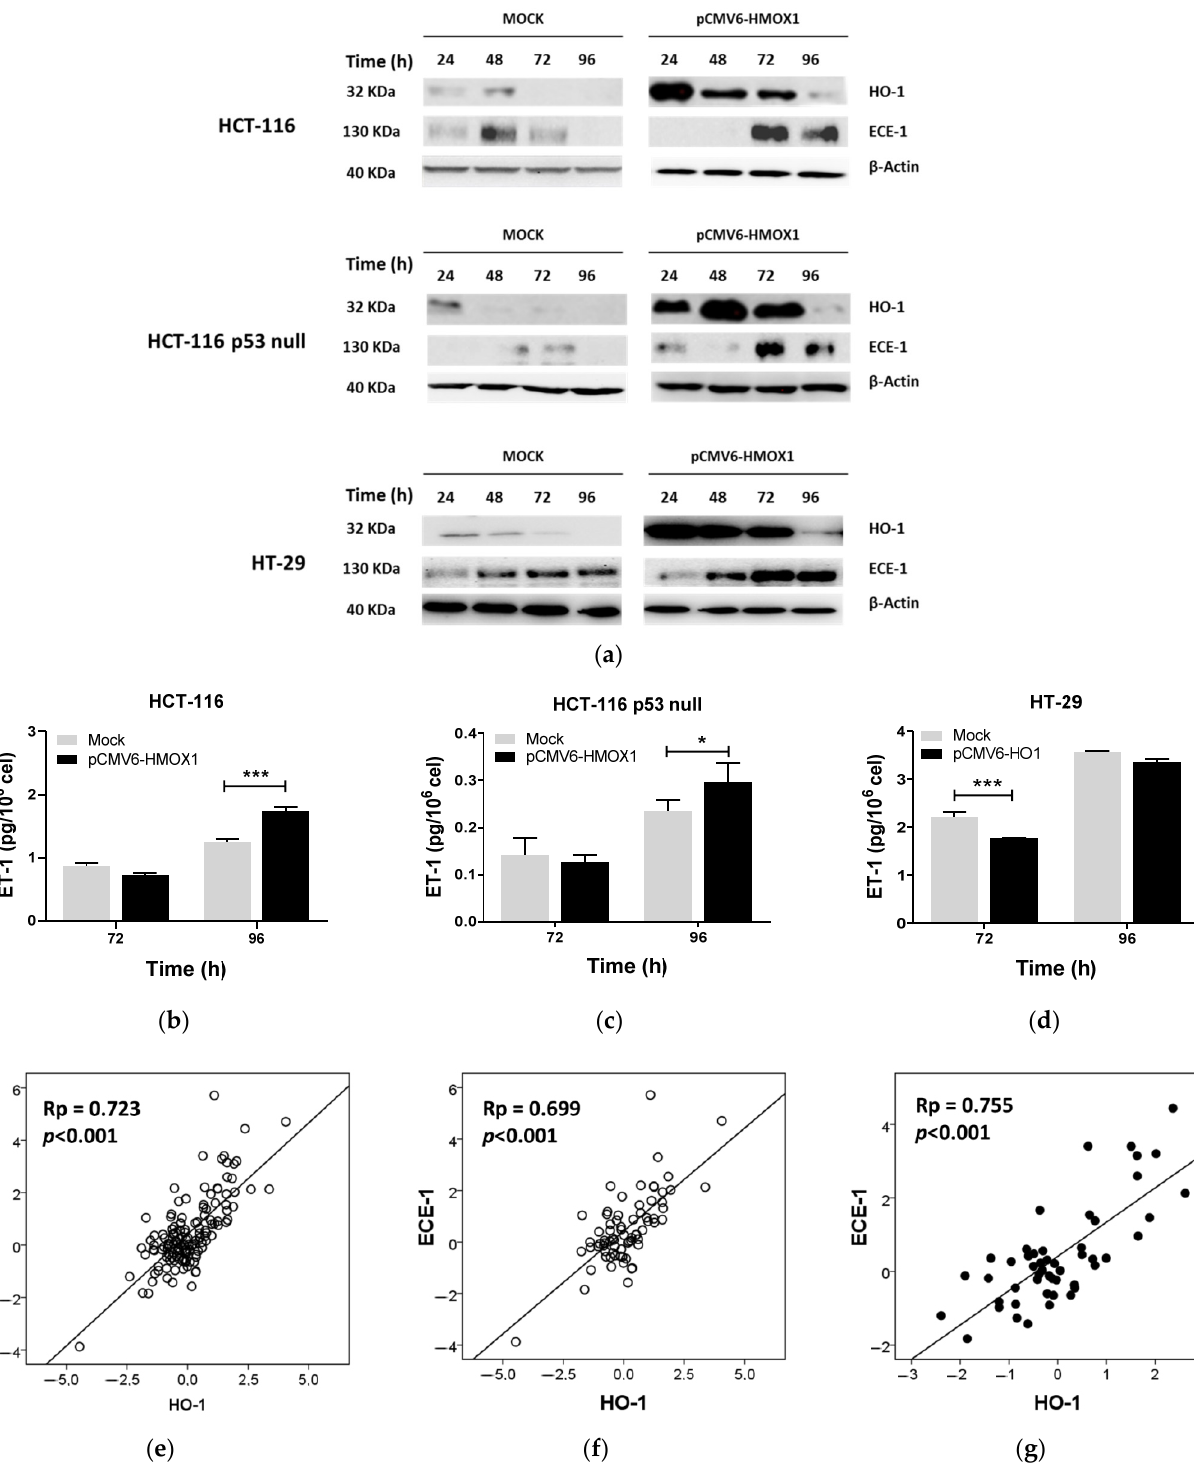
Figure 4. HO-1 overexpression induces ECE-1 expression and ET-1 production in CRC cells regardless of p53 status. Cells were transiently transfected with pCMV6- HMOX1 or an empty vector and collected 24–96 h later for ( a ) HO-1 and ECE-1 protein expression by western blotting or ET-1 measurements in the supernatants of ( b ) HCT-116, ( c ) HCT-116 p53 null, ( d ) and HT-29 cells. Data represent the median ± SD of two experiments in duplicate. *, p < 0.05; ***, p < 0.001. Correlation of ECE-1 and HO-1 expression in tumors from CRC patients considering ( e ) all cases, ( f ) p53 wild-type tumors, and ( g ) p53 mutated tumors.